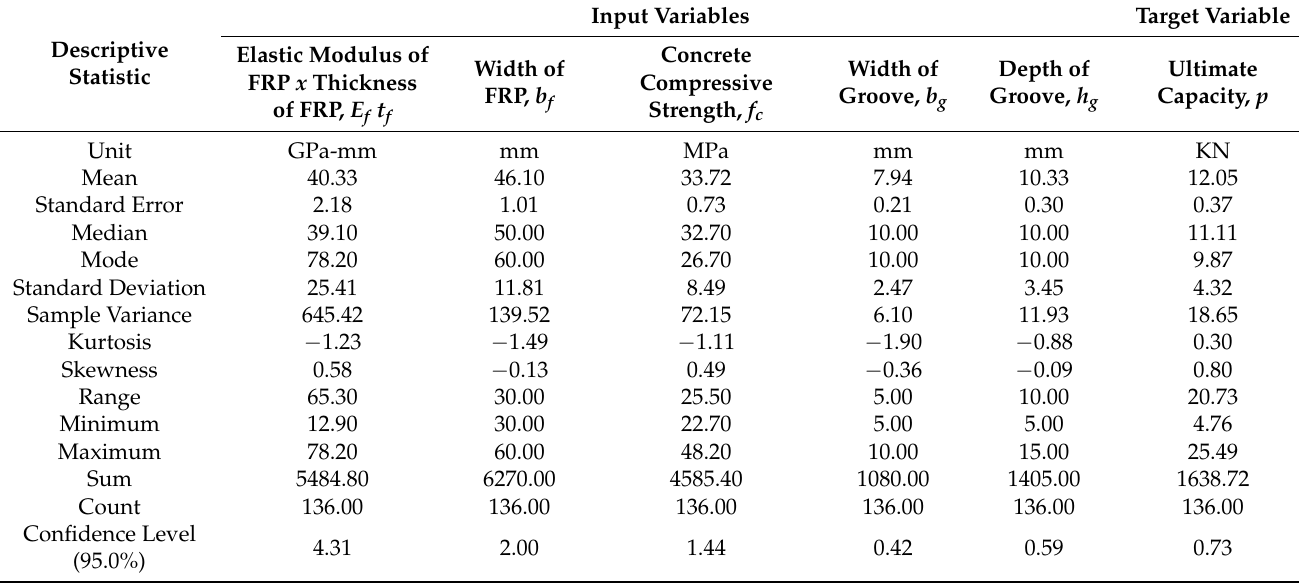
Table 1. Descriptive statistics of the collected dataset